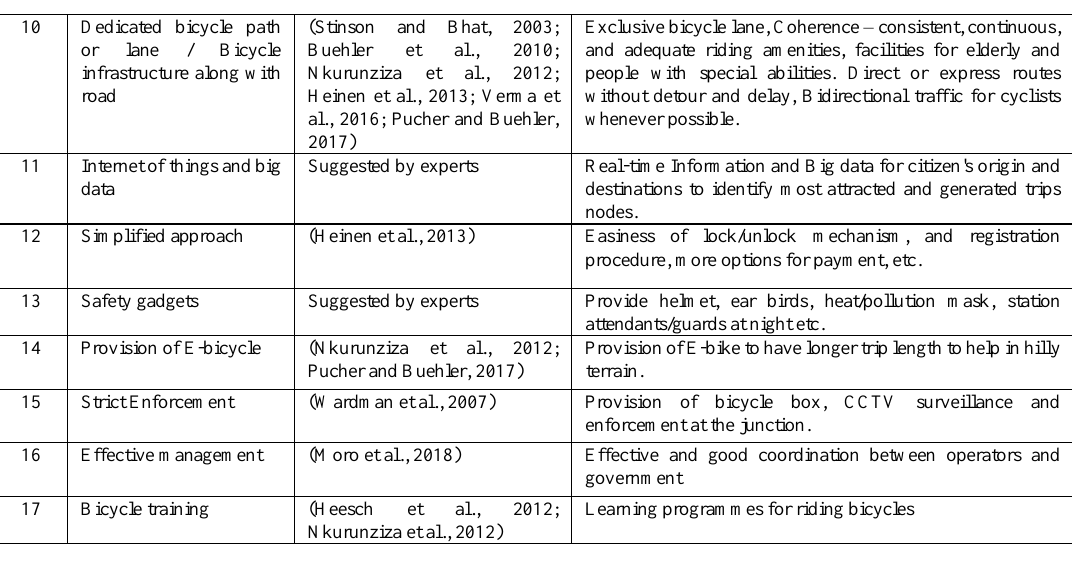
Table 2 continuied